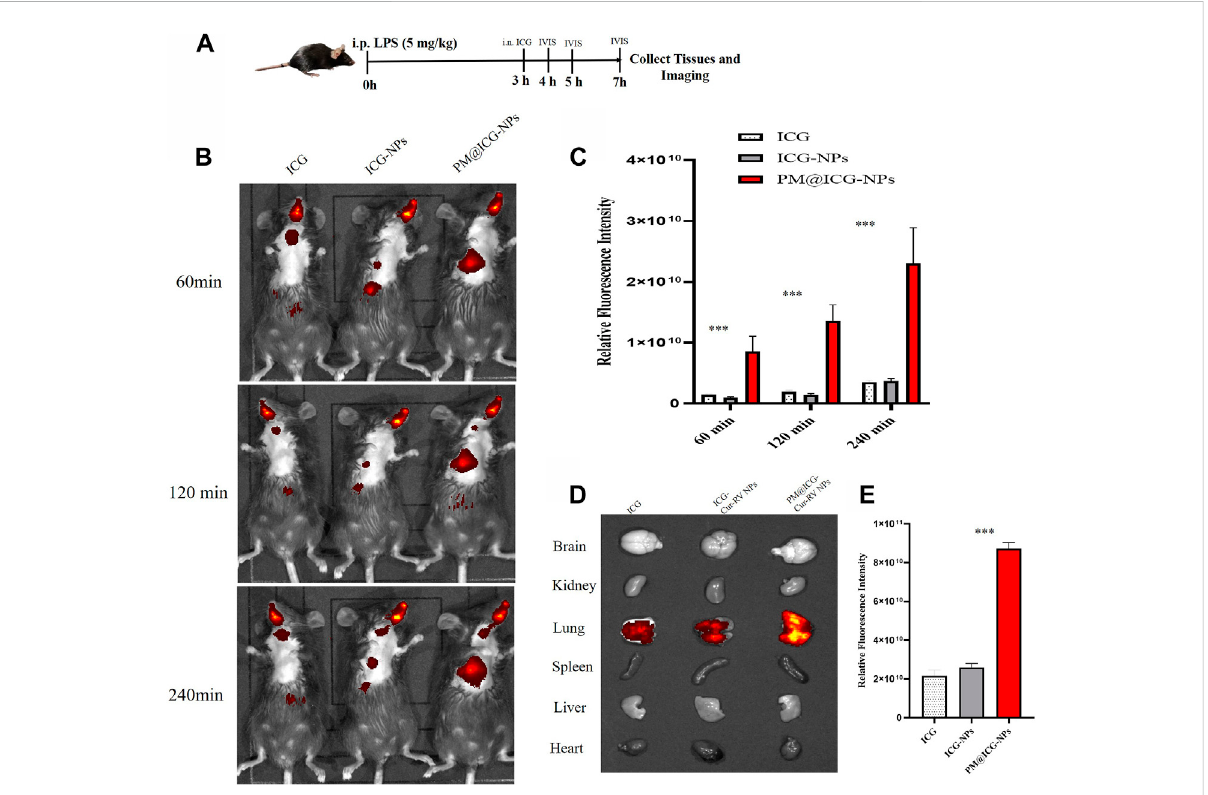
FIGURE 3 In vivo targeting of different modi fi ed NPs. Indocyanine green (ICG) were co-loaded into the NPs as a fl uorescent marker of nanoparticles. (A) SchemeoftimeaxisshowstheIVISimagingofALImice:themicewereintraperitoneal(i.p.)administratedwithLPS(5 mg/kg)toinduceALImodeland at 3 h post LPS challenging, the mice were intranasally administrated with different formulations of ICG. (B) Representative IVIS imaging of free ICG, ICG-NPs or PM@ICG-NPs distributed in sepsis mice at 1, 2, and 4 h after intranasal administration of ICG. (C) Relative fl uorescence intensity of ICG in Figure B, which was measured with Living Image 4.5 software. Data are expressed as mean ± SD (n = 4). * p < 0.05, ** p < 0.01 versus ICG group. (D) Typical fl uorescenceimagingofmainorgansoriginatedfromALImiceafterintranasalofNar-NPswithorwithoutPMmodi fi cationfor4 h. (E) Relative fl uorescence intensity of ICG in Figure D, calculating with Living Image 4.5